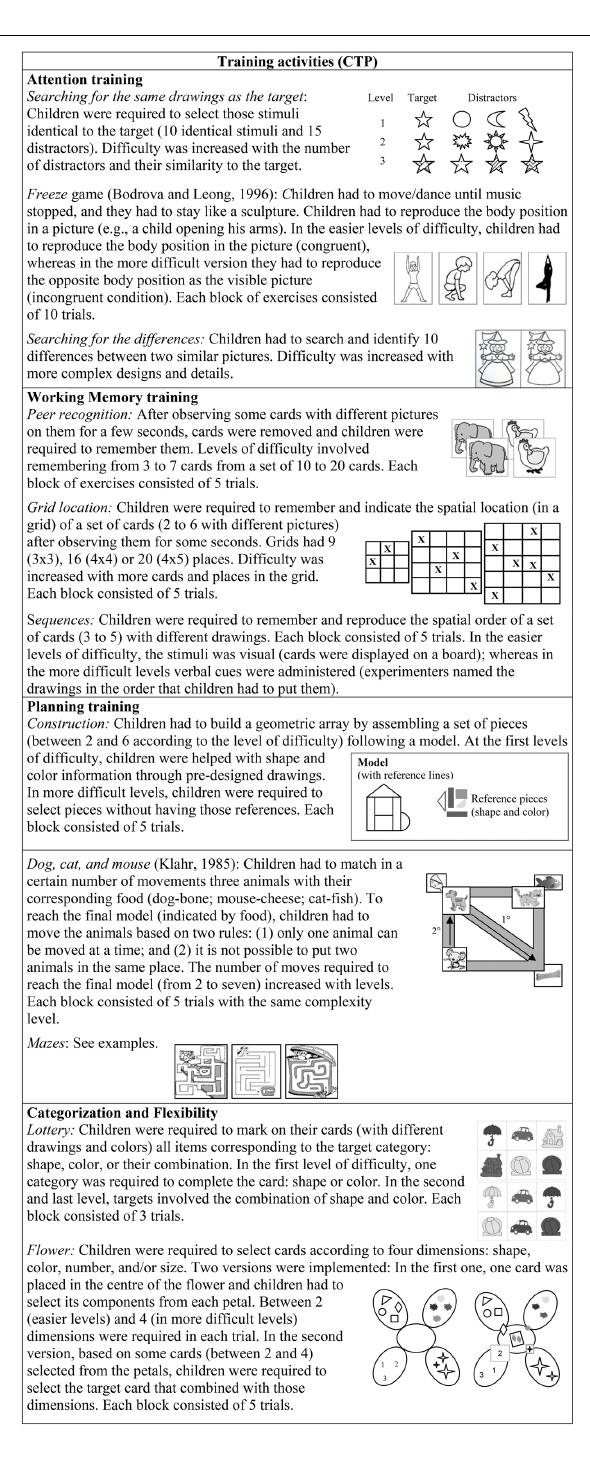
FIGURE 3 | Description of training activities in the